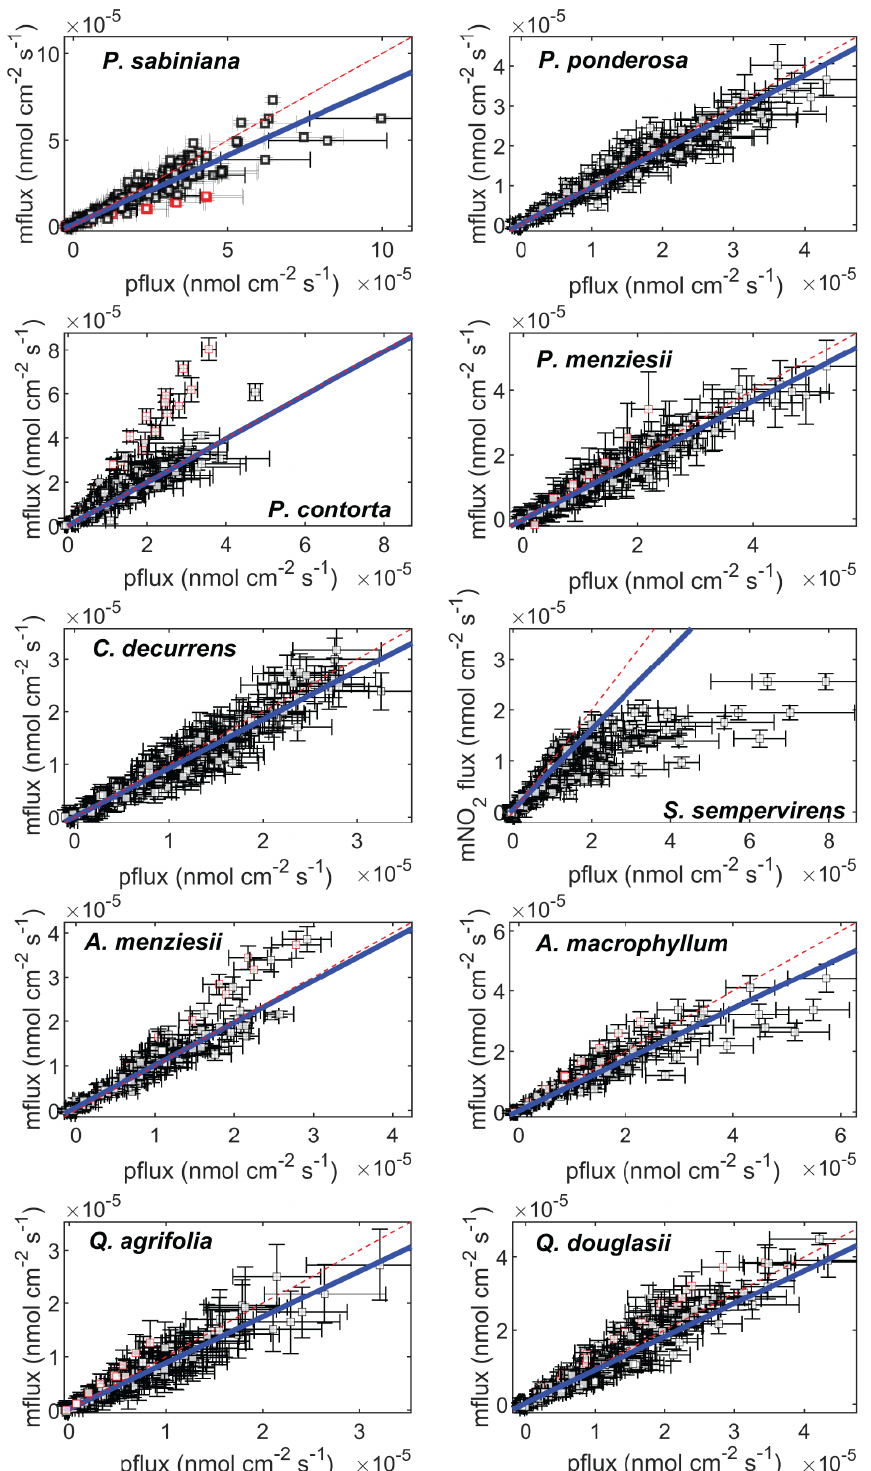
Figure 2. Measured fluxes (mflux) plotted against stomatally limited predicted fluxes (pflux = g t [ NO 2 ] out ). Drought data and nitrogen fertilization data are included. Blue solid lines are the linear fit to data. Red lines are the 1 : 1 line. Error bars for the measured fluxes are calculated by propagating uncertainty in the measured NO 2 mixing ratios, the flow rate, and the leaf area (Eq. 1). Error bars for the predicted fluxes are calculated by propagating uncertainties in the measured NO 2 mixing ratios and the total conductance (Eq. 8). Red markers indicate data determined to be outliers by a generalized extreme studentized deviate test for